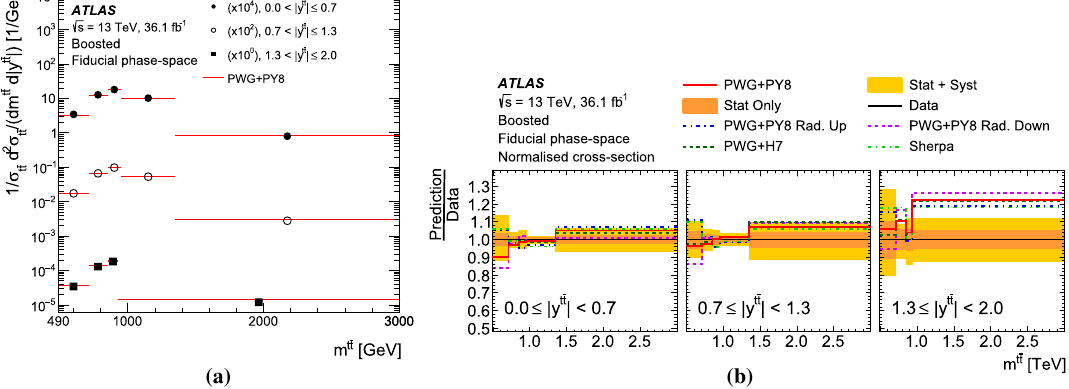
Fig. 49 a Particle-levelnormaliseddifferentialcross-sectionasafunc- tion of the mass of the t ¯ t system in bins of | y t ¯ t | in the boosted topology compared with the prediction obtained with the Powheg + Pythia8 MC